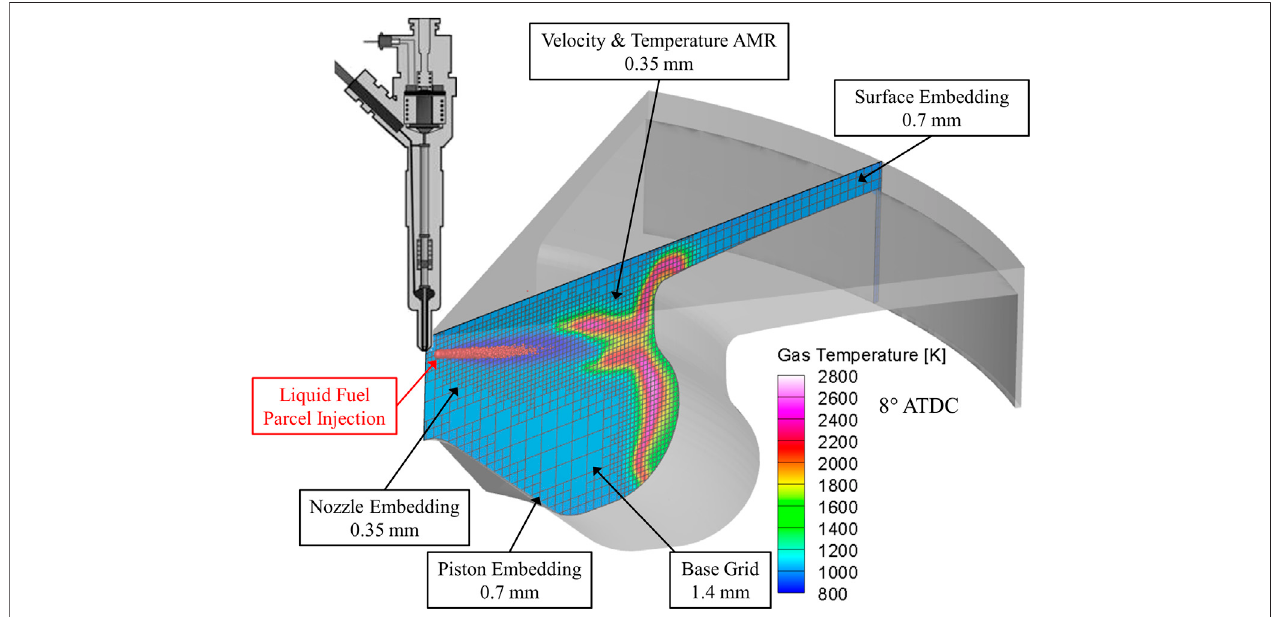
FIGURE2| SectorsimulationoftheCDCoperatingconditionillustratingthecomputationalgridsettings.Verticalcutplanecoloredbygastemperatureonthespray axis at 8 ° ATDC.